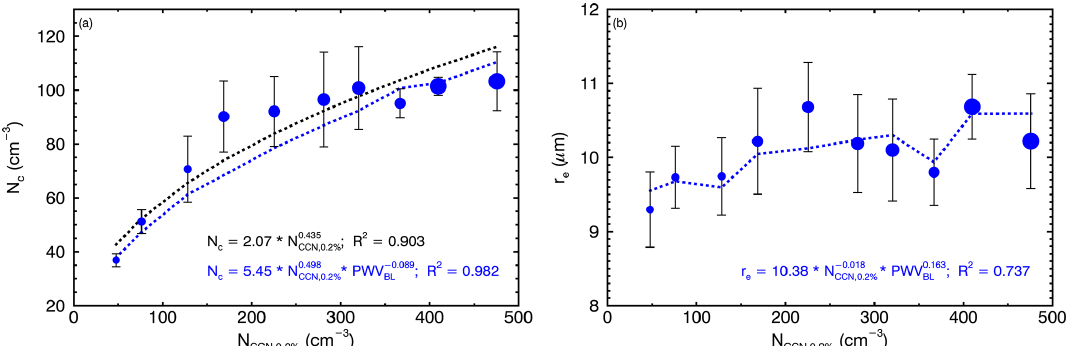
Figure 2. (a) N c and (b) r e as a function of N CCN , 0 . 2% ( x axis) and PWV (filled blue circles) for all selected samples. The larger blue circles represent higher PWV values. Whiskers denote 1 standard deviation for each